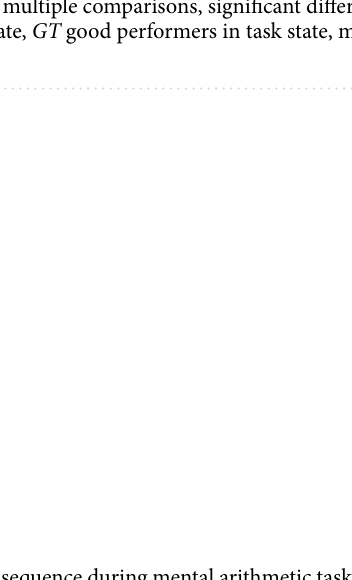
Figure 4. Directional predominance of microstate sequence during mental arithmetic task. The letters in the circle represent the microstate of each type. Solid arrows indicate that the transition from one microstate to another is significantly increased compared to the opposite direction between two groups after Bonferroni– Holm correction. The dotted line indicates that there is no statistical significance, and the direction is indicated by arrows in comparison with zero. PT poor performers in task state, GT good performers in task